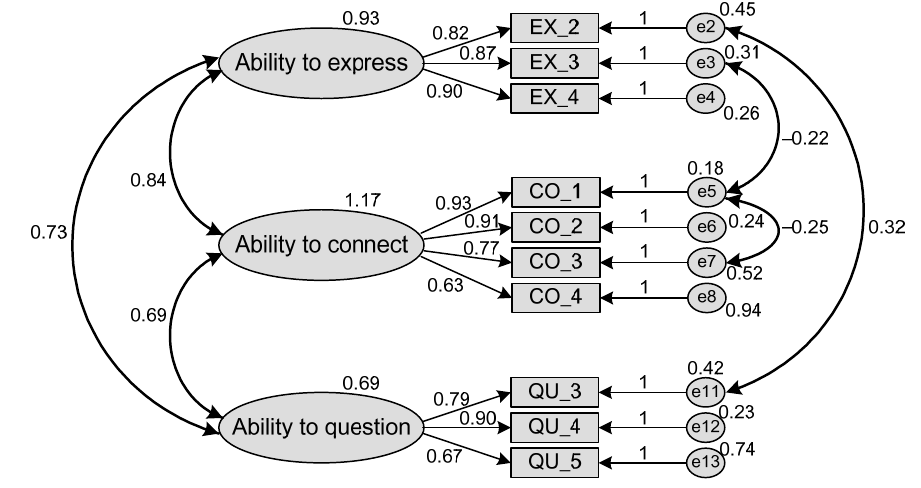
Figure A1. Final confirmatory factor analysis of CPLAS.